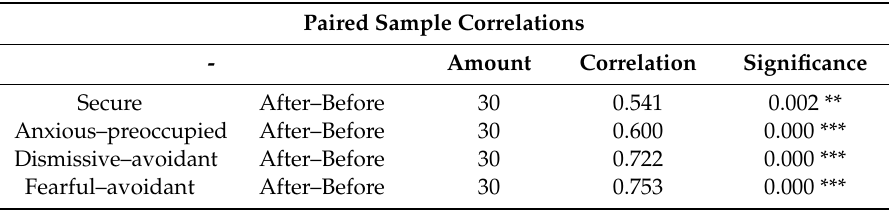
Table 6. Pre- and post-test on correlations for attachment style.